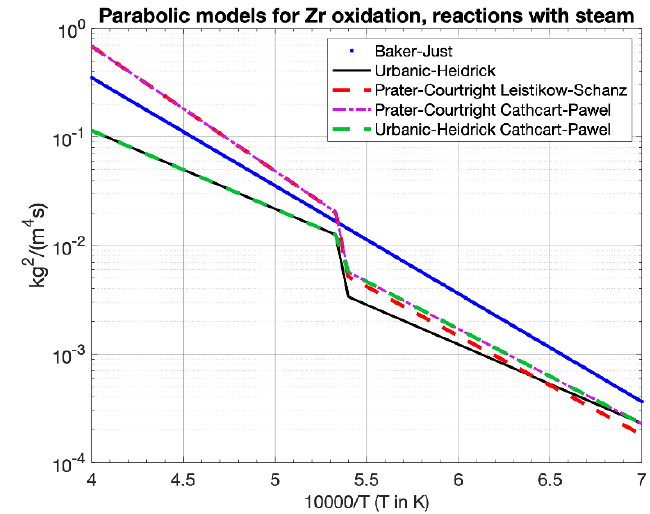
Figure 6. Cladding zirconium–steam oxidation correlations applied in this study. Based on